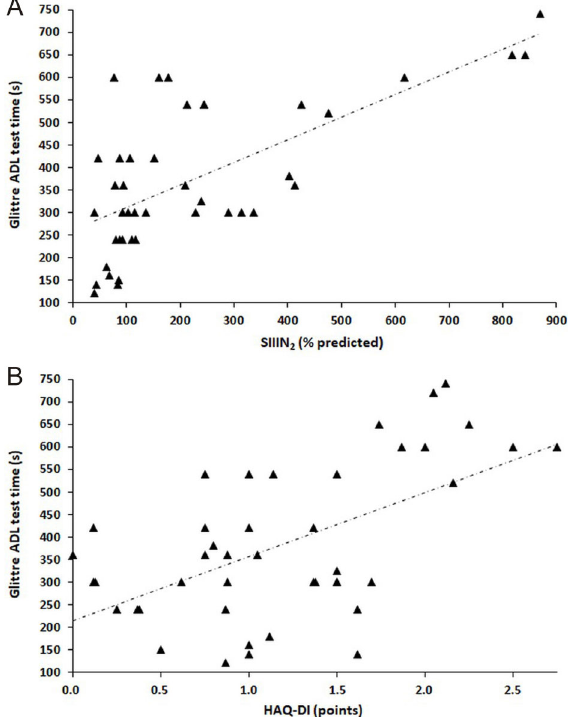
Figure 3. A , Relationship of Glittre activities of daily living (ADLs) test time with the phase III slope of the nitrogen single-breath washout test (SIIIN 2 , r s =0.644, P o 0.0001) and B , with the Health Assessment Questionnaire Disability Index (HAQ-DI, r s =0.482, P=0.001). Spearman ’ s correlation test was used for statistical